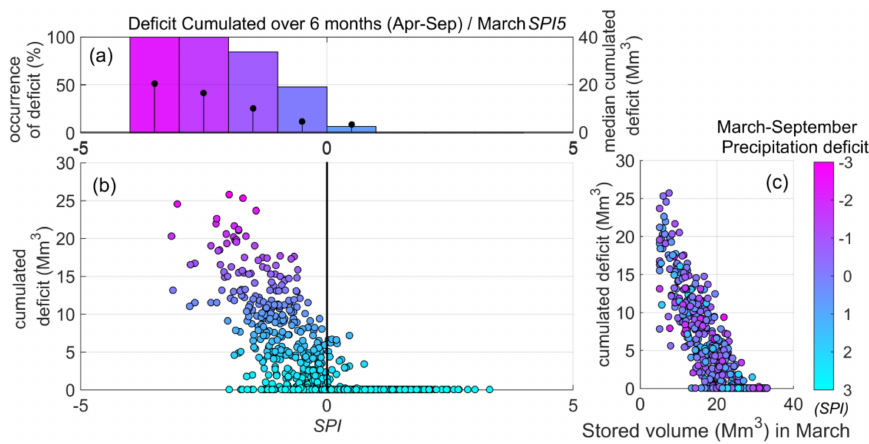
Figure 2. Support-to-early warning graphical analysis. ( a ) Occurrence of deficit (colored bars, principal y axis) and median cumulated deficit (stems, secondary y axis) for each class of Standardized Precipitation Index ( SPI ). ( b ) Cumulated deficit for each shortage episode as a function of the correspondent SPI . Color code refers to the cumulated deficit. ( c ) Cumulated deficit over 6 months as a function of the volume stored in March. Color code refers to the SPI value. The example refers to the Ridracoli case study (month of analysis: March; predictor: SPI 6; forecast time window: 5 months).